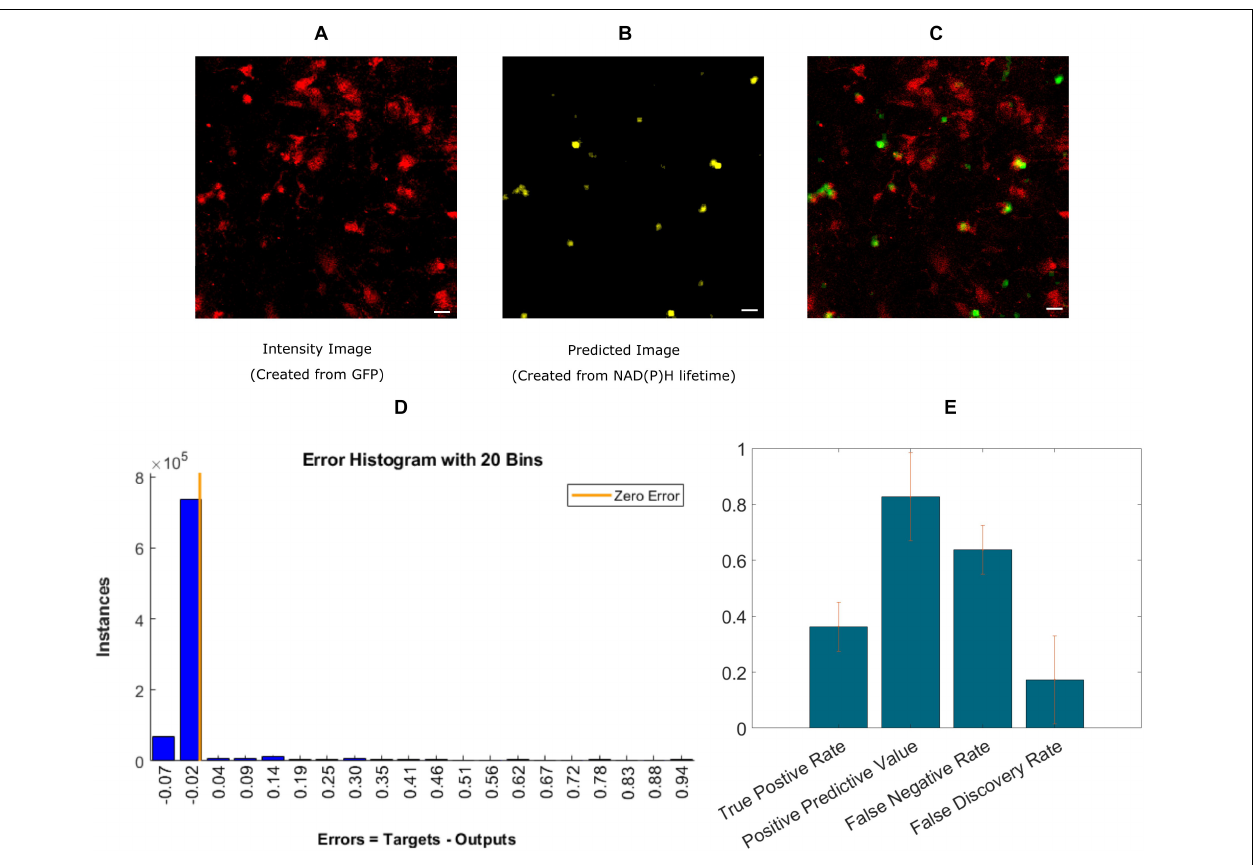
FIGURE 4 | Prediction of microglia from NAD(P)H lifetime data in mixed glial cell cultures where microglia cells are GFP-labeled. In this approach, ANN is applied directly on exponential decay curves of the endogenous fluorophore NAD(P)H. (A) Original intensity image of microglia location created from the GFP channel (B) Predicted microglia image from NAD(P)H lifetime data only. Both images are from the same field-of-view. (C) Composite image of predicted microglia image and original intensity image. (D) Error rate from training and (E) TPR, PPV, FNV, and FDR from five different dishes (Scale bar 20 µ m, A–C